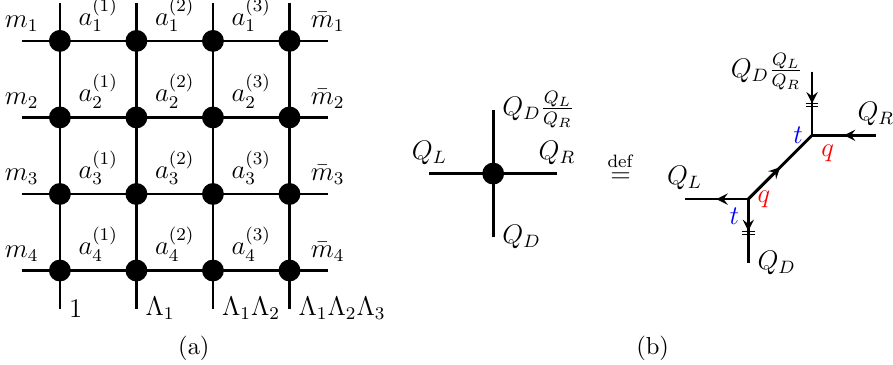
Figure 7 . (a) The toric diagram S producing the square gauge theory from (cid:12)gure 5. The labels of the lines correspond to the spectral parameters on the toric diagram and encode the parameters of the gauge theory. (b) The shorthand notation for the crossings: black circles denote the resolved conifold geometries with general K(cid:127)ahler parameters. Notice that the spectral parameter on the upper vertical leg is determined by the \conservation